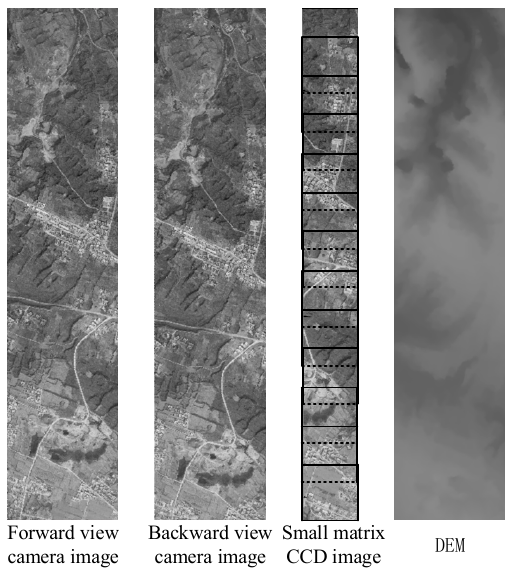
Figure 8. Simulation image schematic of the linear array charge-coupled device (CCD) and the small matrix CCD. Table 3. Simulation results for symmetry and vertical accuracy. Table 3. Simulation results for symmetry and vertical accuracy.